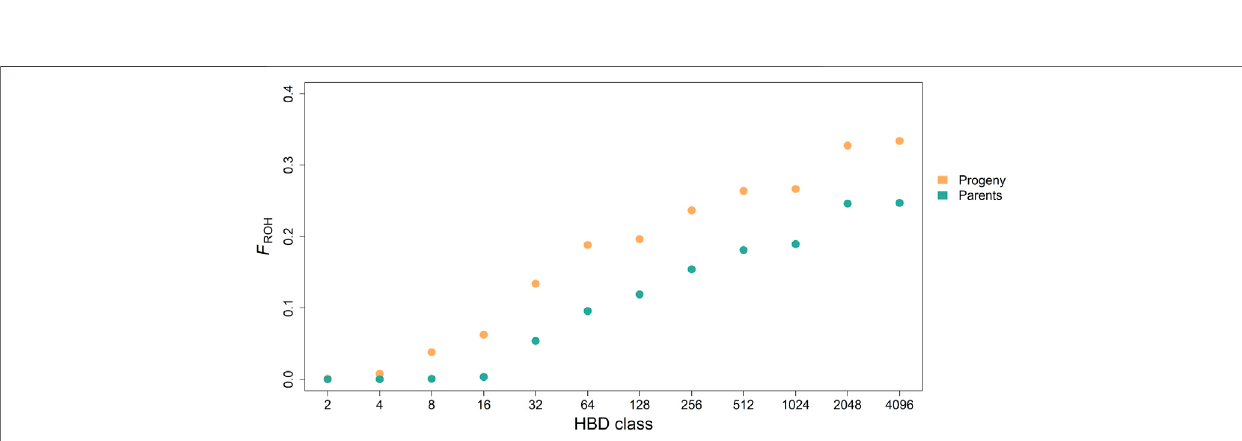
FIGURE3| Accumulatedaverageinbreedingcoef fi cients( F ROH )throughthedifferenthomozygous-by-descent(HBD)classesforprogenyandparentalgeneration.